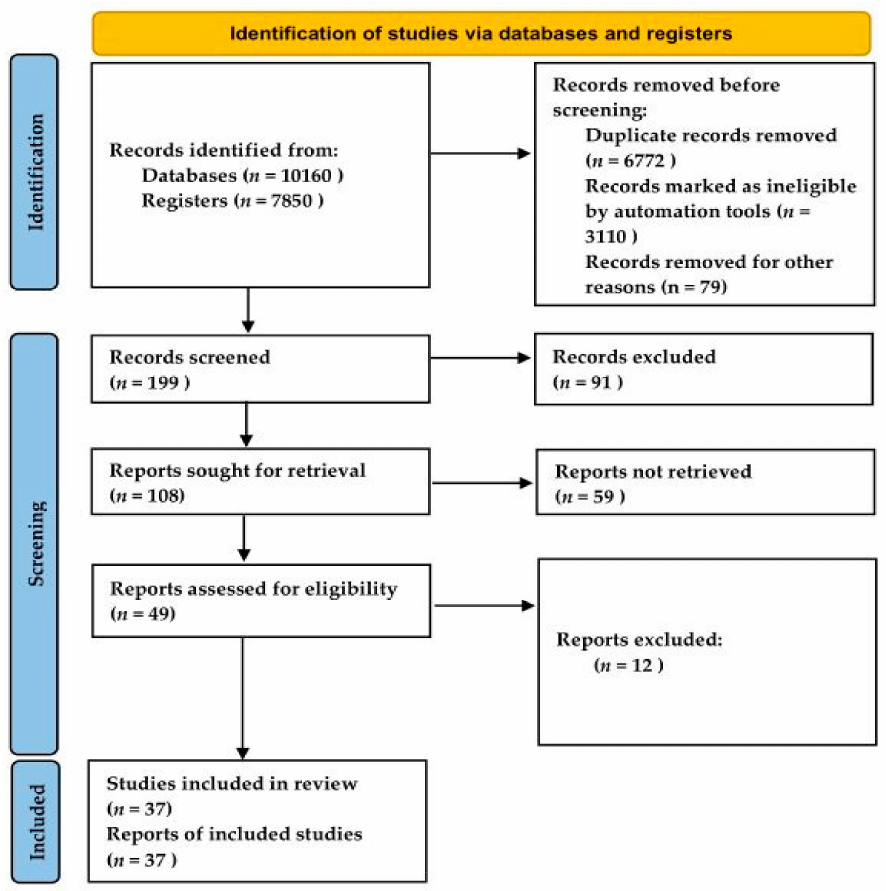
Figure 1. PRISMA flow chart of Paper search for systematic review on diagnostic tools and interven- tion methods for